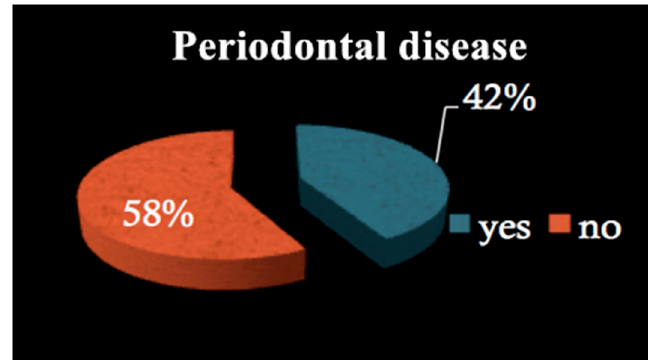
Figure 4. Periodontal disease.